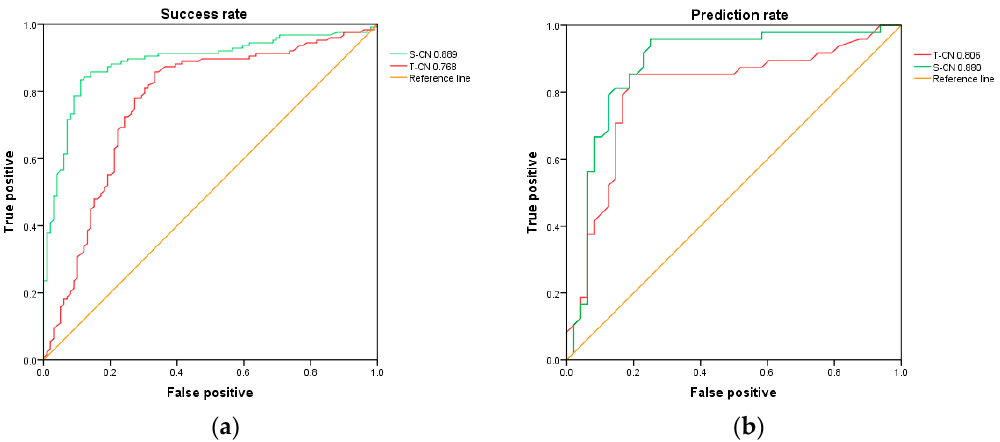
Figure 14. Validation of debris flow prediction results: ( a ) success rate curve and ( b ) prediction rate curve.